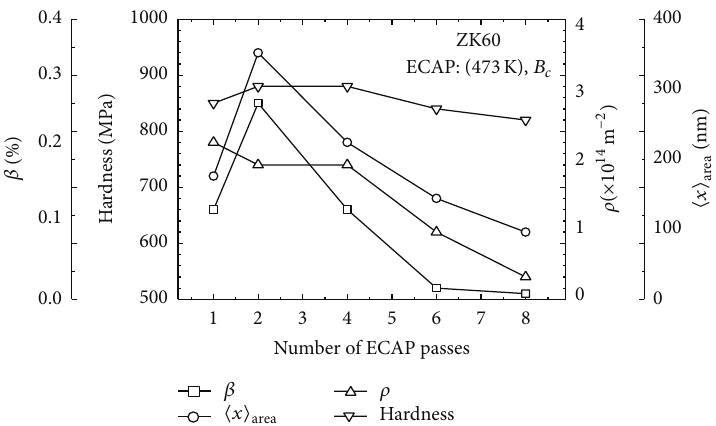
Figure 12: Hardness, twin boundary density 𝛽 , dislocation density 𝜌 , and average area mean subgrain size ⟨𝑥⟩ area as a function of the number of ECAP passes